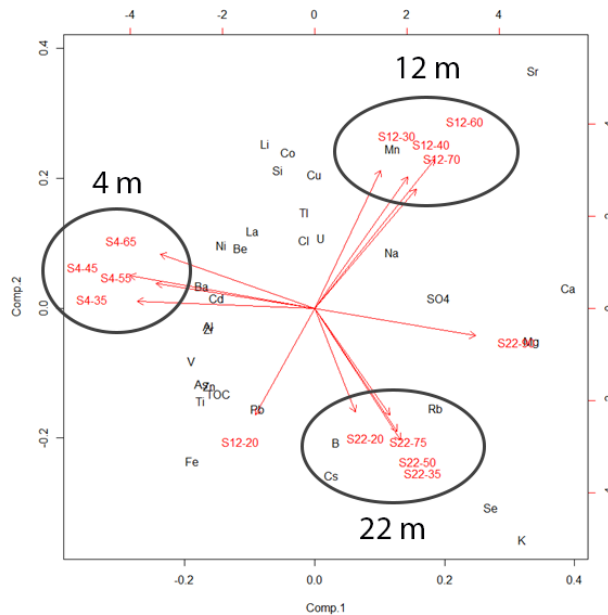
Figure 3. PCA biplot for the average concentrations in each of the lysimeters. Most lysimeters located at the same distance from the stream ended up close to one